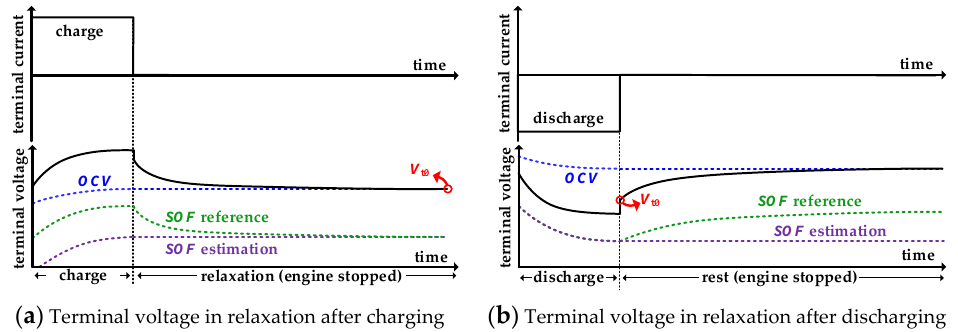
Figure 9. Effects of polarization voltage for terminal voltage and V t0 according to applied terminal current.